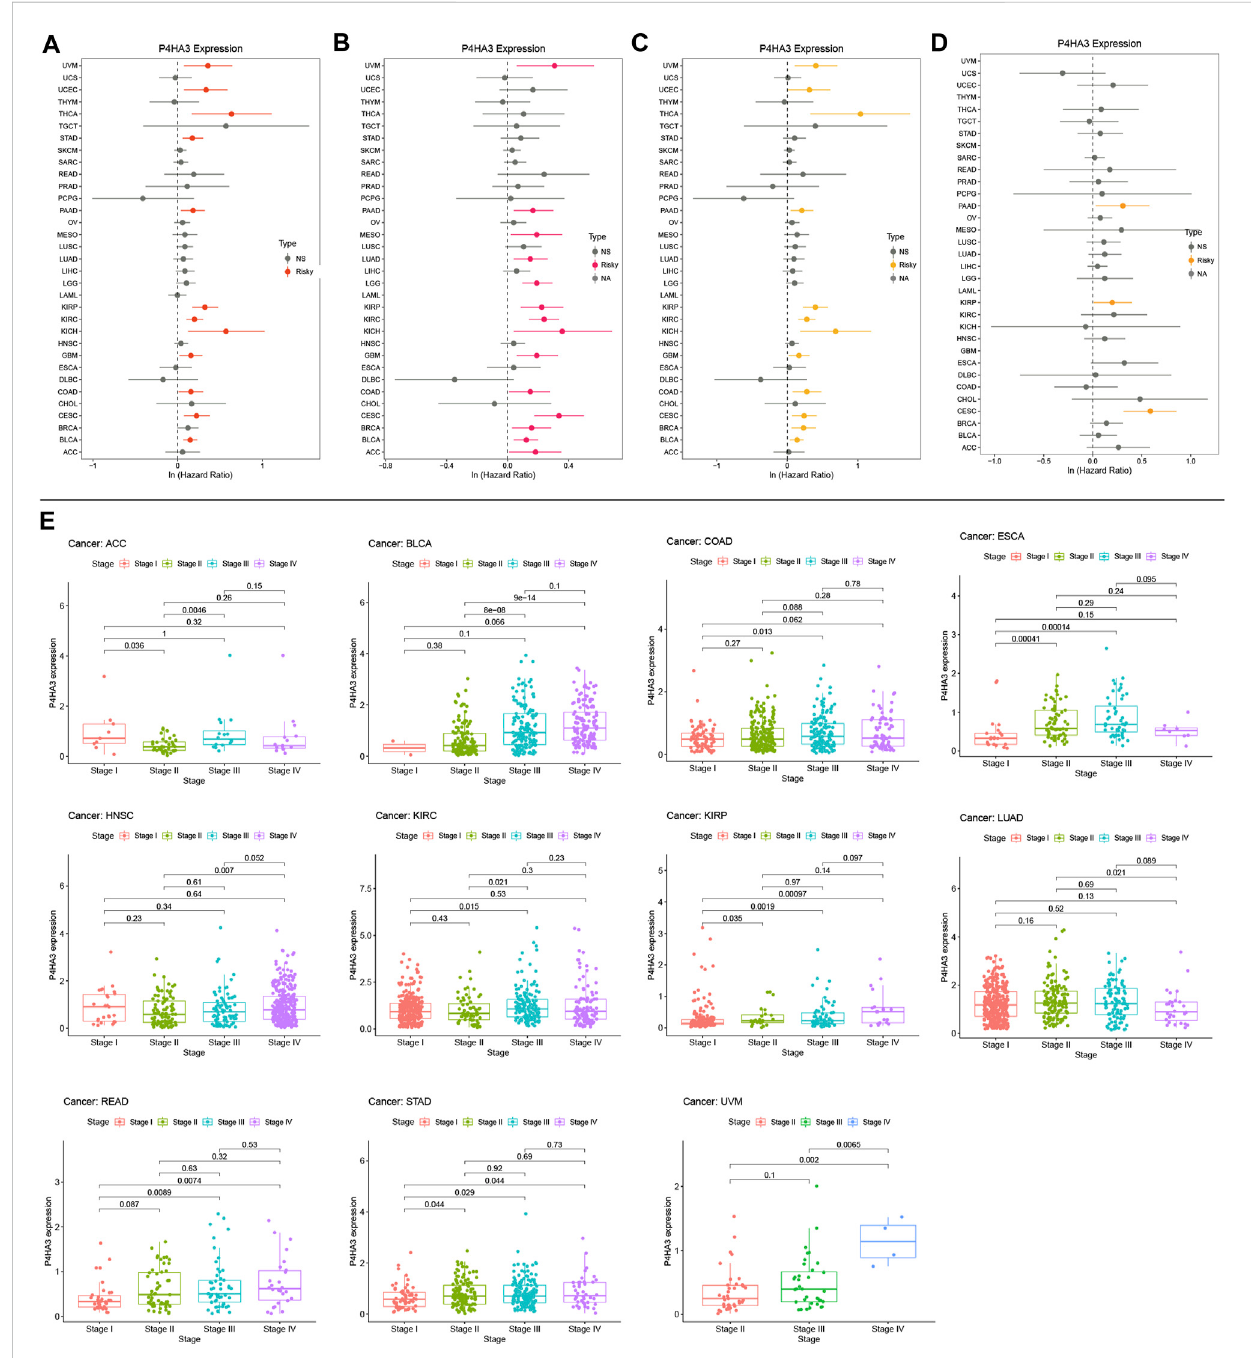
FIGURE 4 Correlation between P4HA3 expression with prognosis and clinical stage in cancer patients. Forest plots of hazard ratios of P4HA3 in (A) overall survival (OS) (B) progression-free interval (PFI) (C) disease-speci fi c survival (DSS), and (D) disease-free interval (DFI). Red and yellow indicates that P4HA3 isariskfactorfortheprognosisofcancerpatients,whilegreyrepresentsaprotectivefactor. (E) Thedifferenceof P4HA3 expressionlevelbetweendistinct clinical stages in ACC, BLCA, COAD, ESCA, HNSC, KIRC, KIRP, LUAD, READ, STAD, and